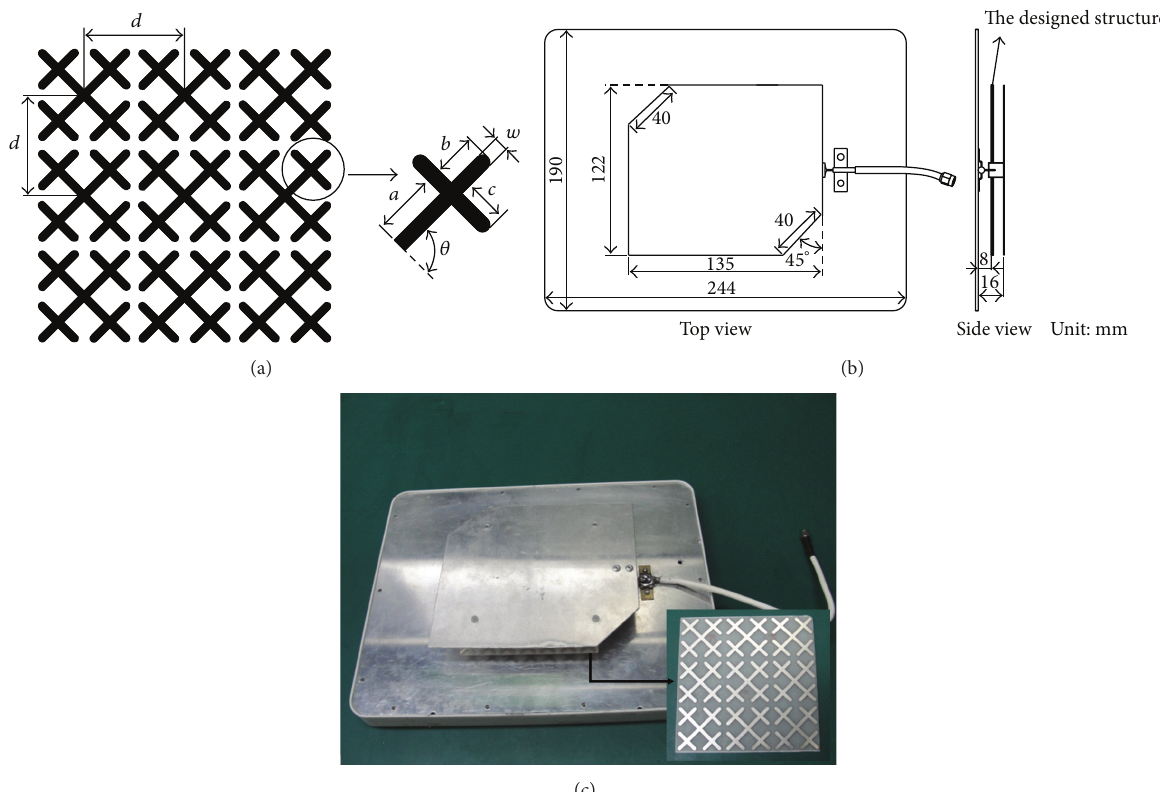
Figure1:(a)Thestructureofsecond-iterationcross-shapedstructure.(b)Geometryoftheproposedantenna.(c)Photographofthefabricated antenna.